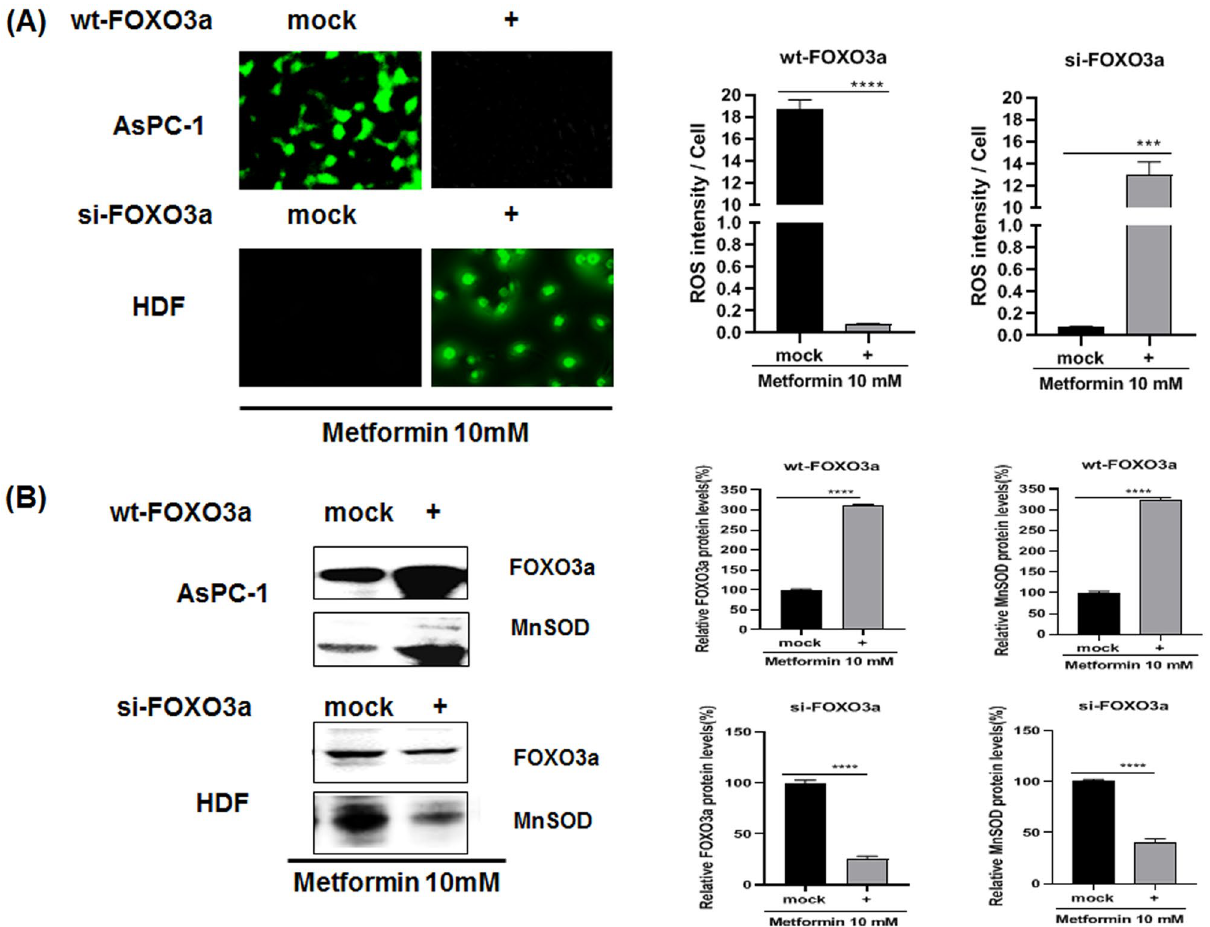
Figure 3. Effect of transfection with si-FOXO3a RNA or wt-FOXO3a plasmids on cellular ROS and protein levels in metformin-treated AsPC-1 and HDF cells. ( A ) Cellular ROS level of metformin-treated (for 24 h) AsPC-1 and HDF cells were measured by CellROX Green staining. AsPC-1 cells were transfected with si-FOXO3a RNA while HDF cells were transfected with wt-FOXO3a. The transfected cells were treated with metformin (10 mM) for 24 h; then cellular ROS levels were measured by CellROX Green staining. ( B ) Protein levels of FOXO3a and MnSOD were measured in the transfected and metformin-treated cells by western blot analysis using anti-FOXO3a and MnSOD antibodies. Three different measurements were performed for each sample. Statistical significance is indicated as * p < 0.05, ** p < 0.01, *** p < 0.001, and **** p <